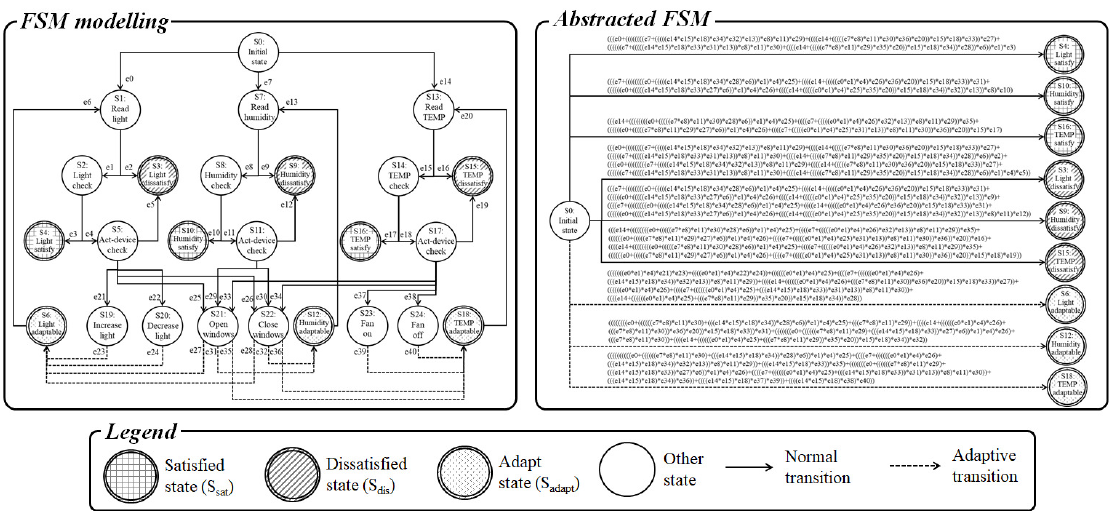
Figure 6. Modeling results of case study.